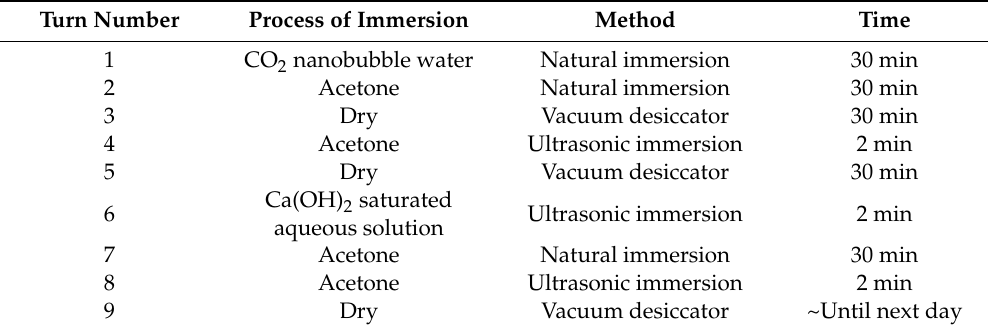
Table 3. CO 2 nanobubble water immersion